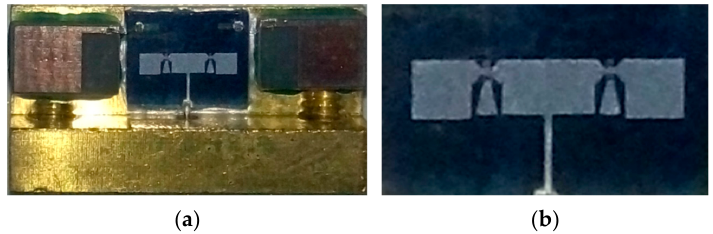
Figure 7. Photograph of the proposed antenna. ( a ) Antenna with testing holder; ( b ) Pure antenna fabricated on high resistivity silicon.